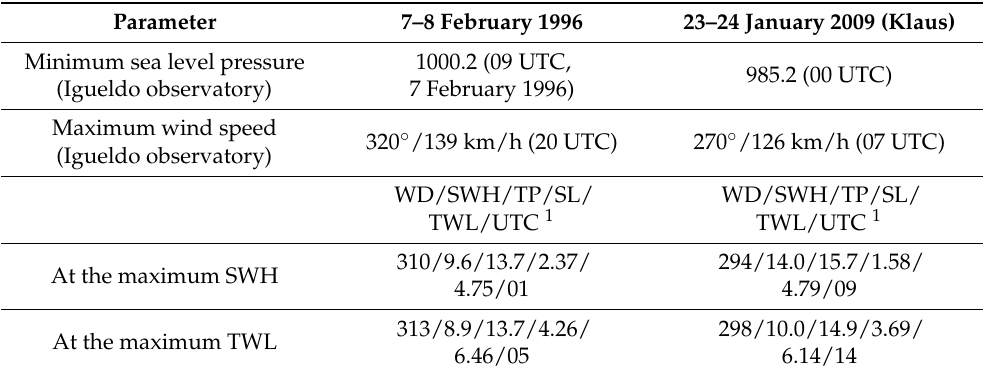
Table 1. Meteorological characteristics of the two major storms that crossed the Bay of Biscay